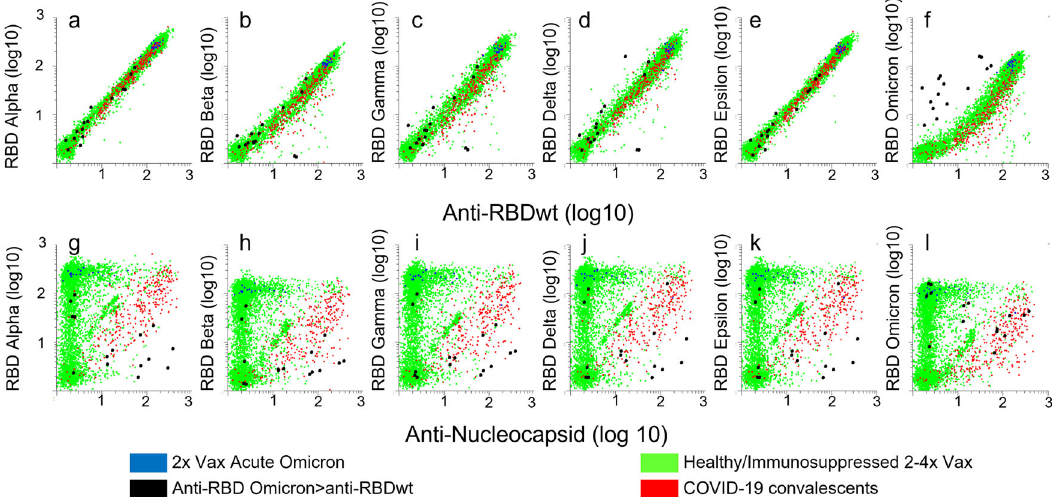
Fig. 2 Correlation between levels of antibodies to RBDs from SARS-CoV-2 variants. The dot plots show accumulated data from array-based measurement of 6693 samples. Each dot in the scatter plots correspond to a different sample. Bead-based arrays were incubated with 6693 sera diluted 1:1000 for 1 h prior to labeling with R-Phycoerythrin-conjugated anti-Human IgG. a – f The x -axes show median fl uorescence intensity (MFI) of anti-human IgG binding to beads coupled with RBDwt divided by MFI measured for beads with no virus protein (relative MFI, rMFI). The y -axes show anti-human IgG rMFI measured for beads coupled with RBDs from indicated variants. g – l The y -axes are the same as in dot plots ( a – f ), while the x -axis shows rMFI for antibodies binding to beads coupled with nucleocapsid from SARS-CoV-2wt. Green dots: post- vaccine sera, red dots: sera obtained in 2020 from SARS-CoV-2 convalescents. Blue dots: sera obtained 10 – 20 days after symptom debut of Omicron BA.1 infection in double-vaccinated healthy individuals. Source data are provided as a Source Data fi le.